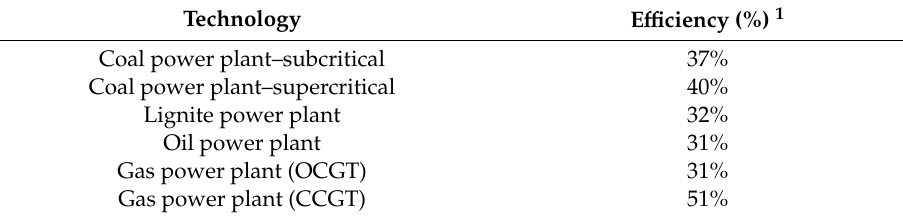
Table A5. Conversion e ffi ciency of various power plant technologies. Data based on References [33,36–39].